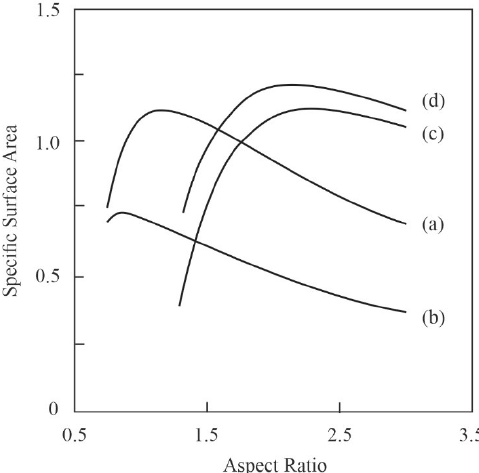
Figure 5. Calculated specific surface areas of the modulated dendritic lattices. The aspect ratios were defined as the numerical proportions of the lattice lengths to diameters. The curved solid lines (a–d) indicate the maximum specific surface areas on the 4-, 6-, 8-, and 12-coordinated lattices, respectively. The streamline distributions of molten salts were visualized to represent fluid move- ments as graphical contrasts with the YSZ lattice models, as shown in Figure 6. These line densities corresponded with the flow rates, and the color tones indicate the flow velocity.